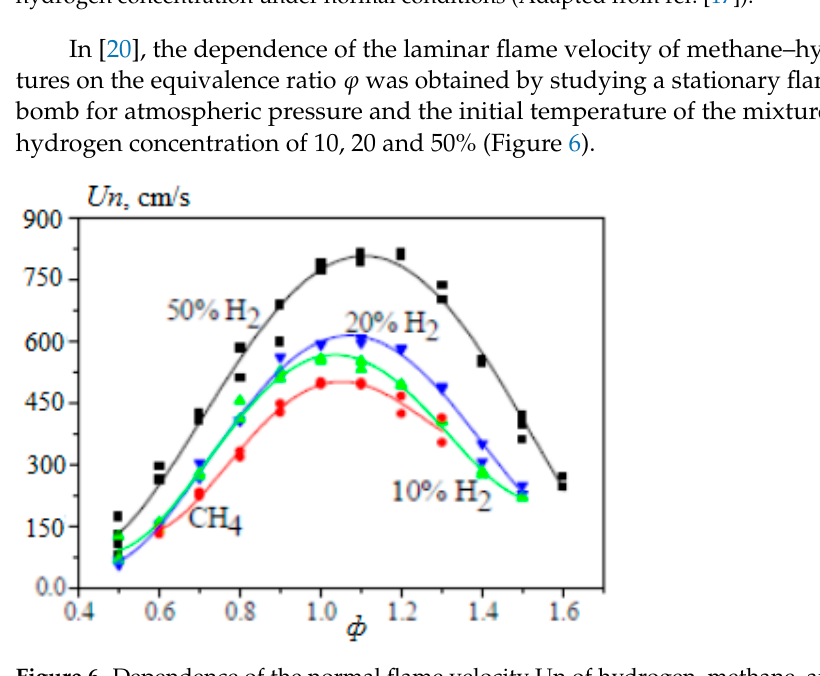
Figure 6. Dependence of the normal flame velocity Un of hydrogen–methane–air mixtures on the equivalence ratio φ under atmosphere pressure and T 0 = 360 K (Adapted with permission from ref. [20], 2007, prof. Prof Alexey Burluka).